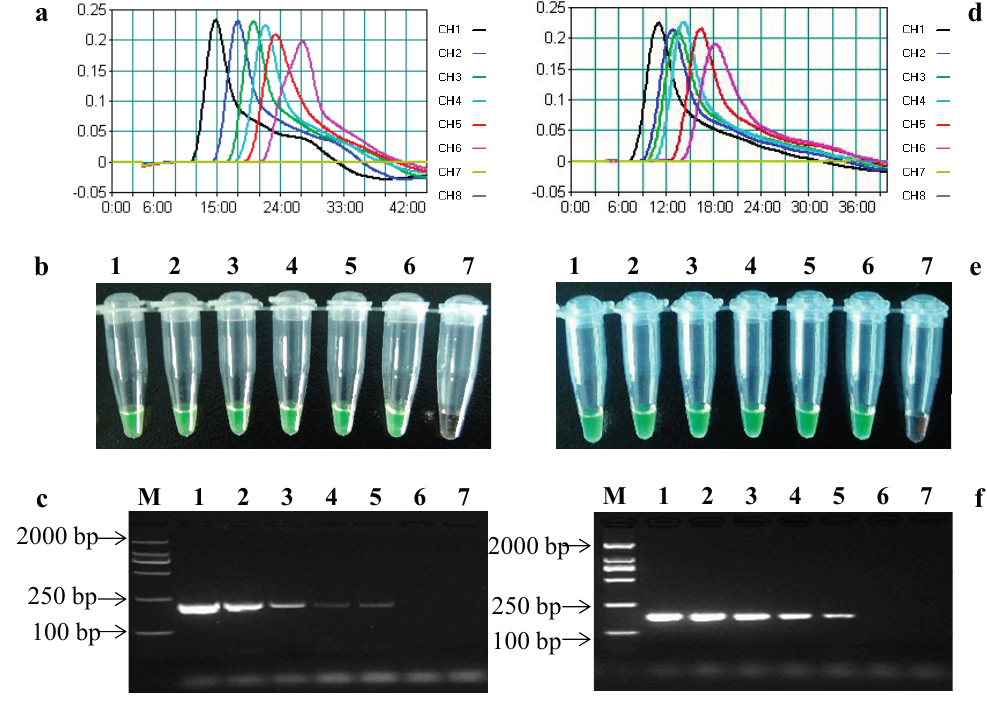
Figure 4. Sensitivity of LAMP assays and conventional PCR for detecting the cry2Ab and cry3A genes. ( a ) The time threshold curves of cry2Ab LAMP assay observed by using the LA-320C turbidimeter. CH1-6, MON89034 genomic DNA samples with final concentrations of 10 4 , 10 3 , 10 2 , 10, 5 and 1 copy/ μ L; CH7, NTC; ( b ) The cry2Ab LAMP assay results using SYBR Green I dye; ( c ) Conventional PCR results of the cry2Ab gene. Lane M, DL2000 DNA marker; Lanes 1–6, MON89034 genomic DNA samples with final concentrations of 10 4 , 10 3 , 10 2 , 10, 5 and 1 copy/ μ L; Lane 7, NTC; ( d ) The time threshold curve of cry3A LAMP assays observed by using the LA-320C turbidimeter. CH1-6, MIR604 genomic DNA samples with final concentrations of 10 4 , 10 3 , 10 2 , 10, 5 and 1 copy/ μ L; CH7, NTC; ( e ) The cry3A LAMP assay results using SYBR Green I dye; and ( f ) Conventional PCR results for the cry3A gene. Lane M, DL2000 DNA marker; Lanes 1–6, MIR604 genomic DNA samples with final concentrations of 10 4 , 10 3 , 10 2 , 10, 5 and 1 copy/ μ L; Lane 7,